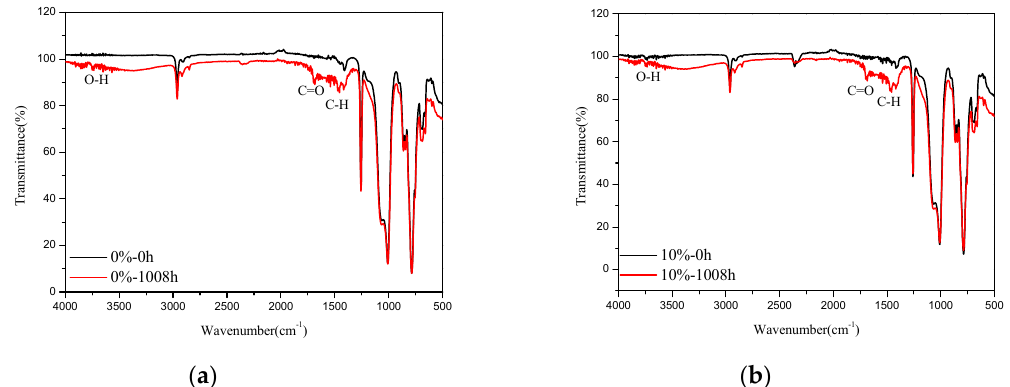
Figure 16. FTIR results of ( a ) silicone and ( b ) 10% phosphor/silicone composite before and after 1008 h high moisture ageing test.